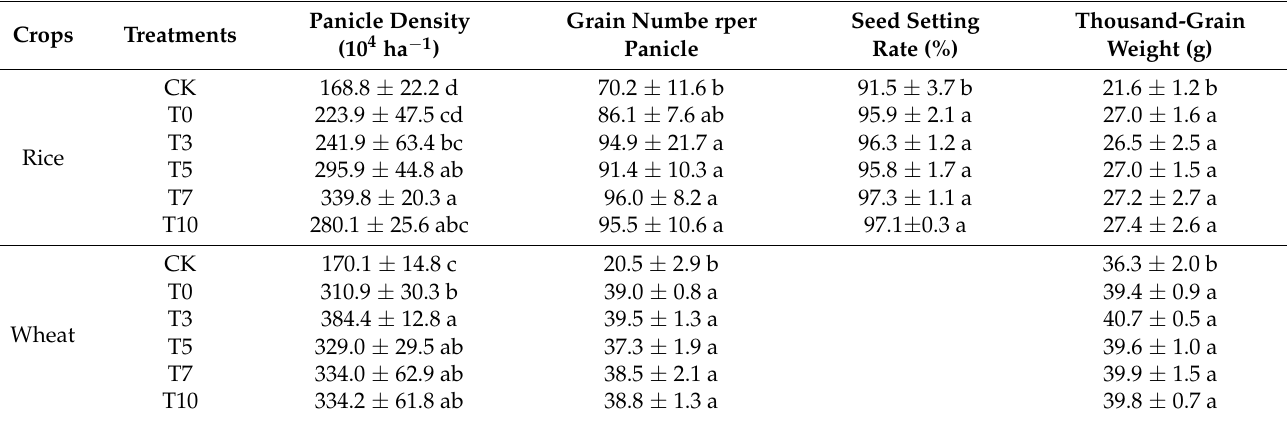
Values are mean ± SD (standard deviation) of four replicates. Columns with different small case letters show significant difference between different treatments at p < 0.05 by LSD’s multiple range test. CK, no nitrogen